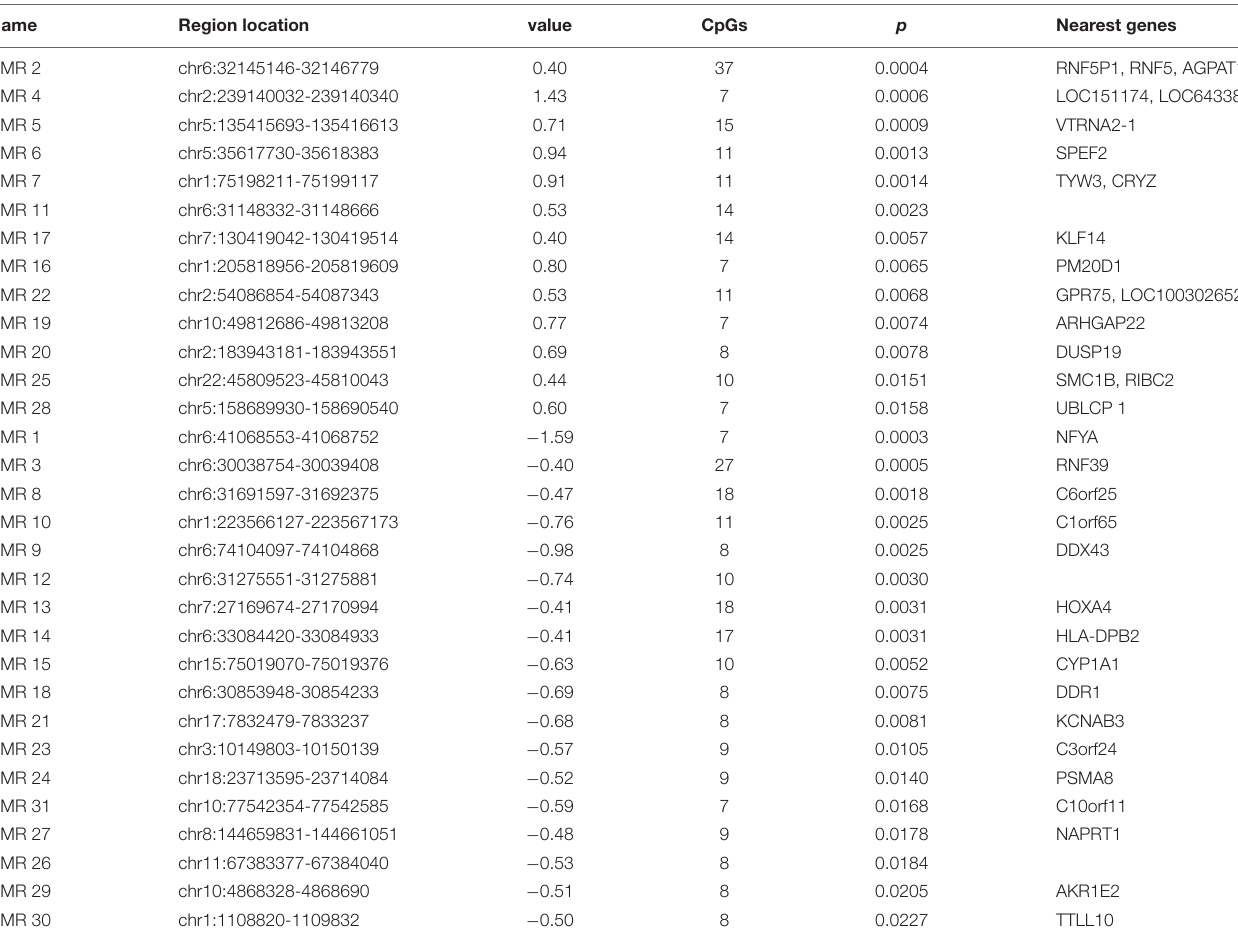
TABLE 3 | Thirteen hypermethylated and 18 hypomethylated in Parkinson’s